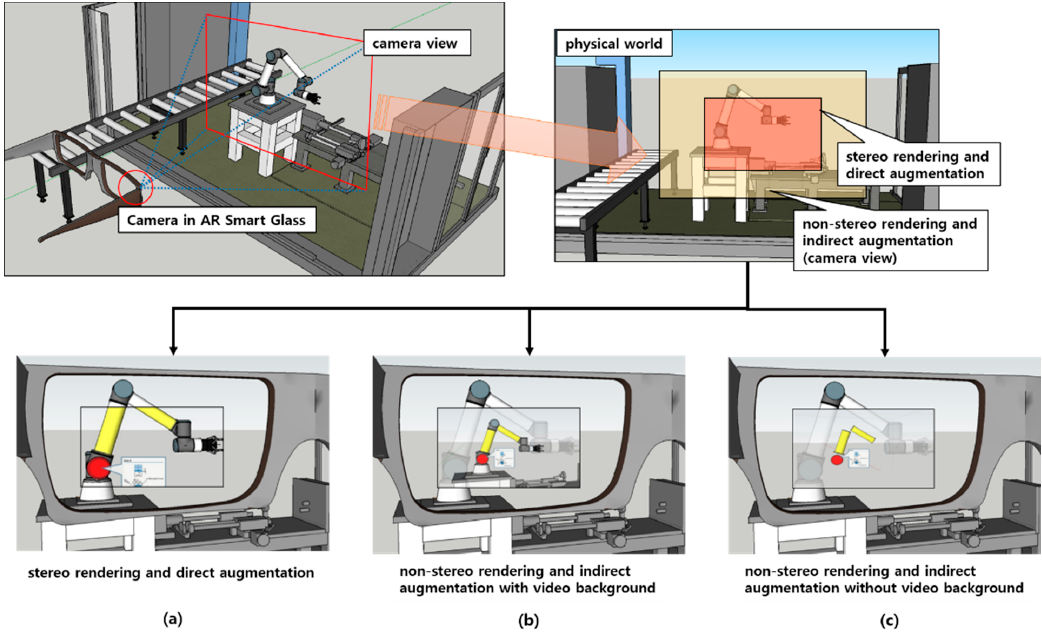
ff erent types of visual contexts for AR smart glasses. Figure 3. Three different types of visual contexts for AR smart glasses. Figure 3. Three di